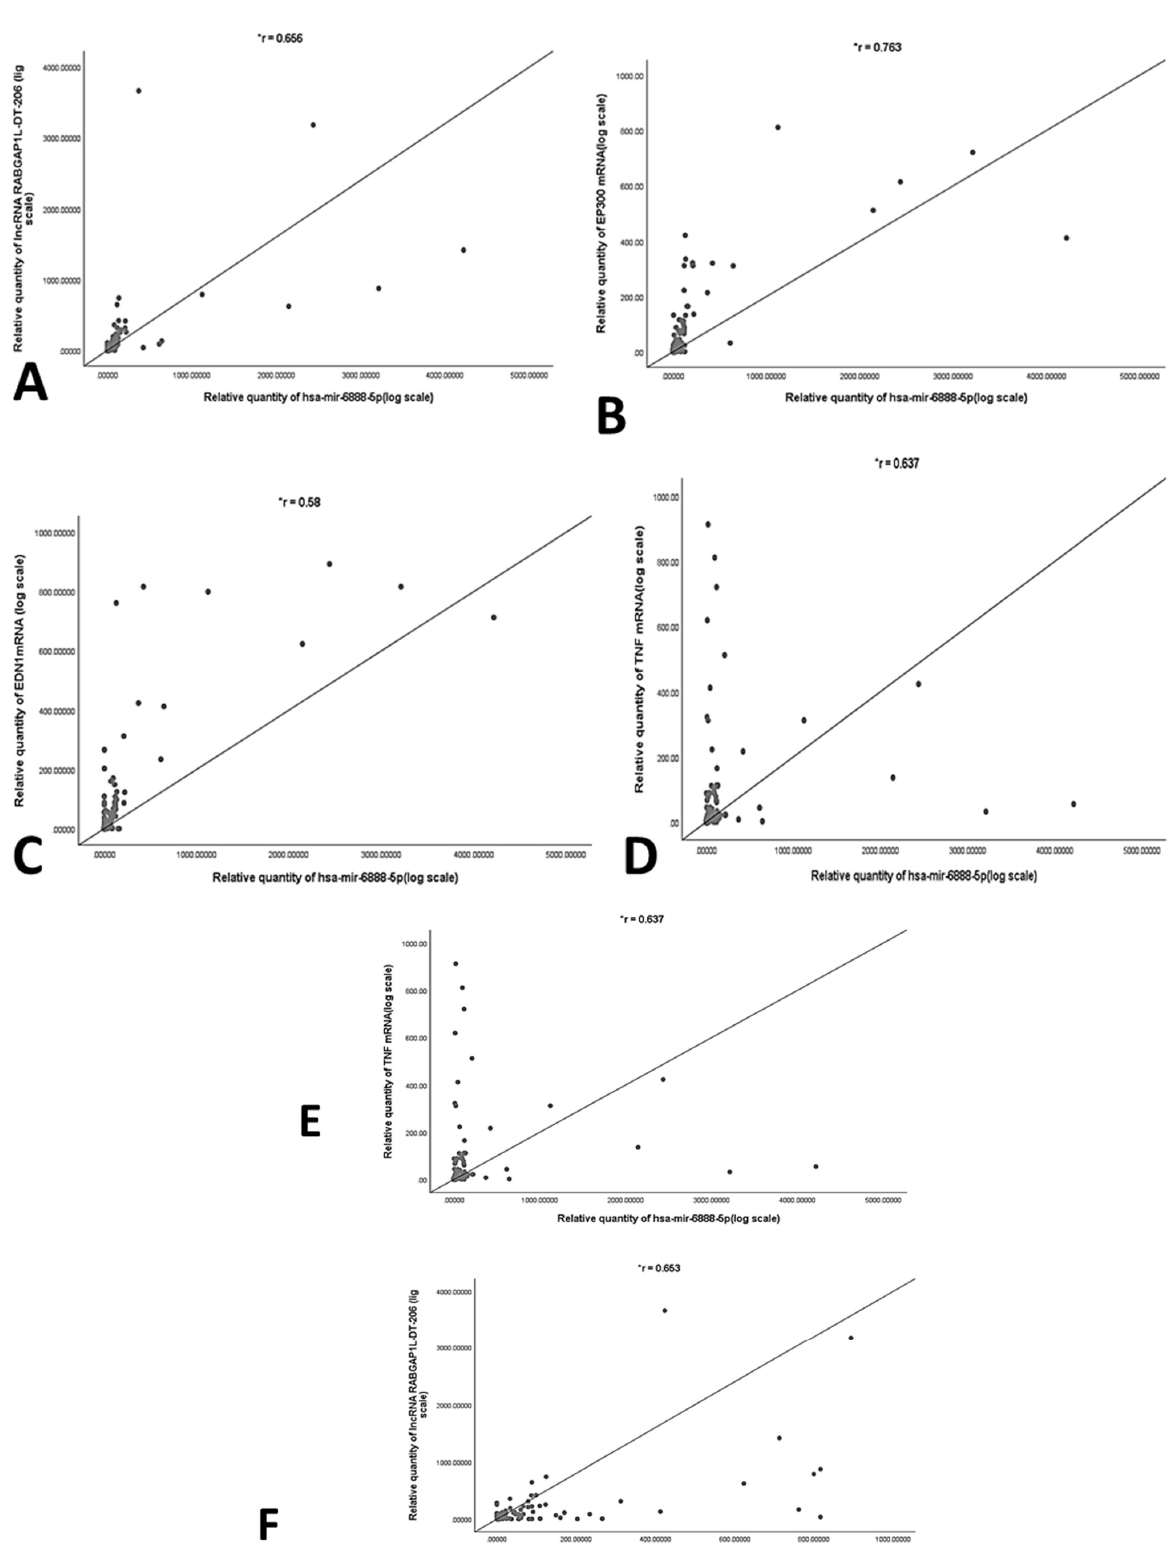
Figure 5. Correlation analysis using spearmen’s coefficient between ( A ) RQ of RABGAP1L-DT-206 and hsa-miR-6888-5p ,